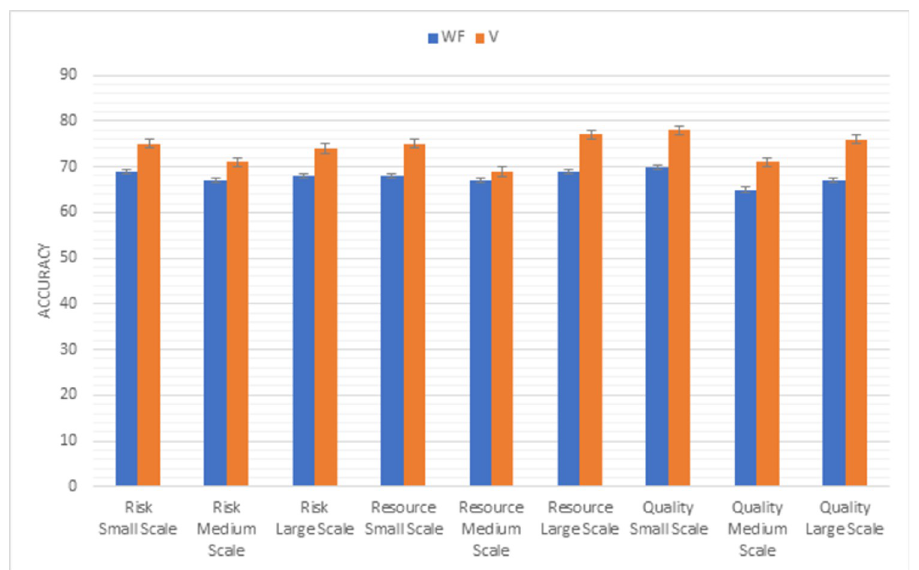
Fig 10. Graphical representation of waterfall vs V (second triangle) results.